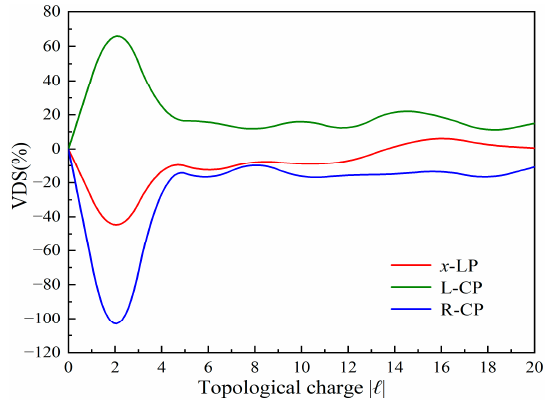
waist radii. radii.